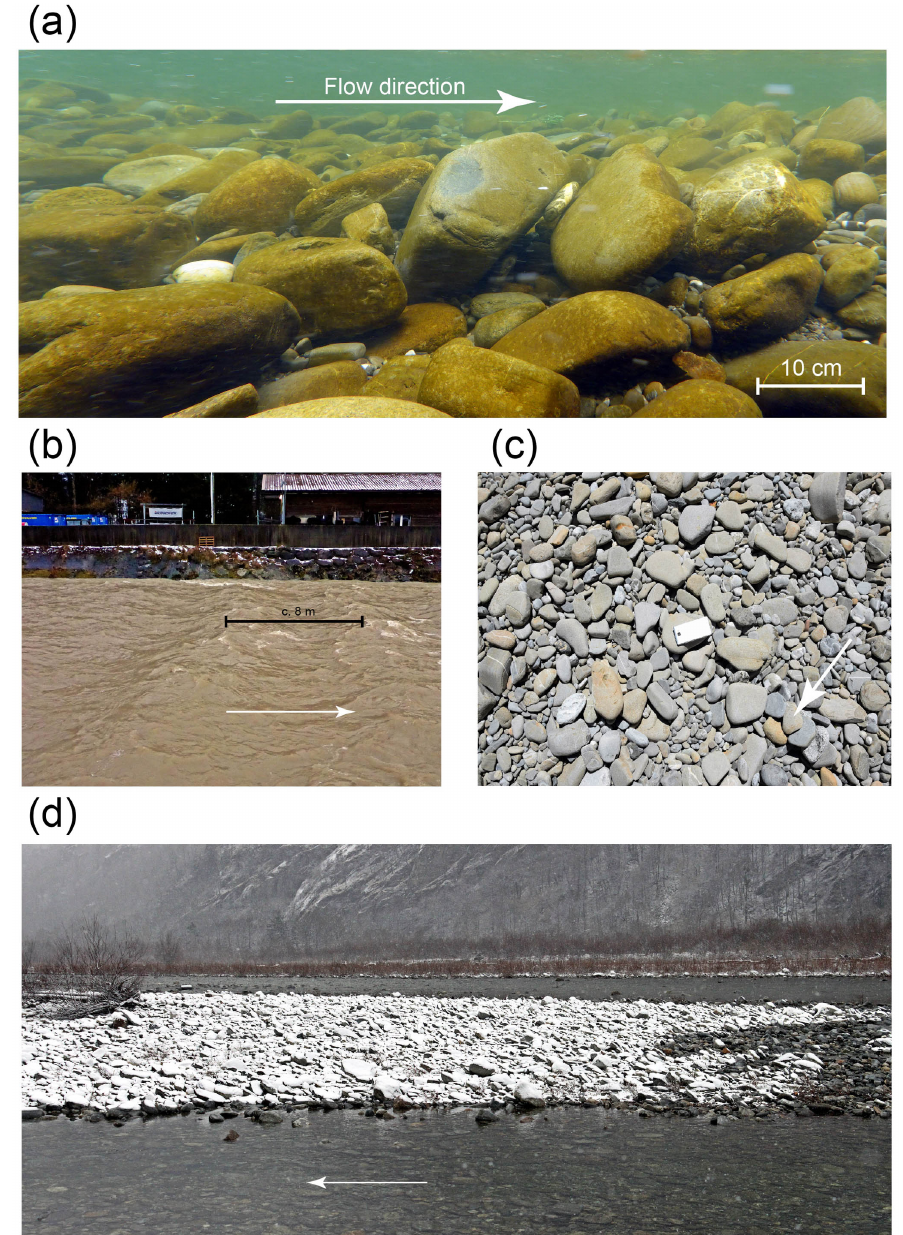
Figure 6. Photos from the field. (a) Photo of a subaquatic longitudinal bar taken along the steep bedrock/gravel bar reach of the Sense river (see Fig. 1b for location of photo). The clasts in the foreground are clustered and imbricated, forming the nucleus of a possible cluster bedform. This fabric most likely formed when rolling clasts came to a halt behind the boulder at the front. The clasts in the background are either flat lying or slightly imbricated. Except for a few sites, nearly all grains are either partially buried by finer-grained material or interlocked by neighboring clasts. The overlying flow shows evidence for supercritical conditions with standing waves. (b) Standing waves with a wavelength of ca. 8m in the Waldemme at Littau. Water fluxes are ca. 100m 3 s − 1 . Arrow indicates flow direction. See also supplement. (c) Flat-lying clasts on a lateral bar in the Sense river. Arrow indicates clasts that are overlapping each other, resulting in a shallow dip of <10 ◦ of the overriding clast. (d) Imbricated clasts within the Maggia river at Visletto. Arrow indicates flow direction. Please note that the imbricated arrangements of clasts mainly include the largest constituents of the gravel bar in the middle of the photo and clasts of similar sizes. Therefore, for this set of imbricated clasts, we do not consider that protrusion effects might play a major role. See Fig. 2 for location and Table 1 for